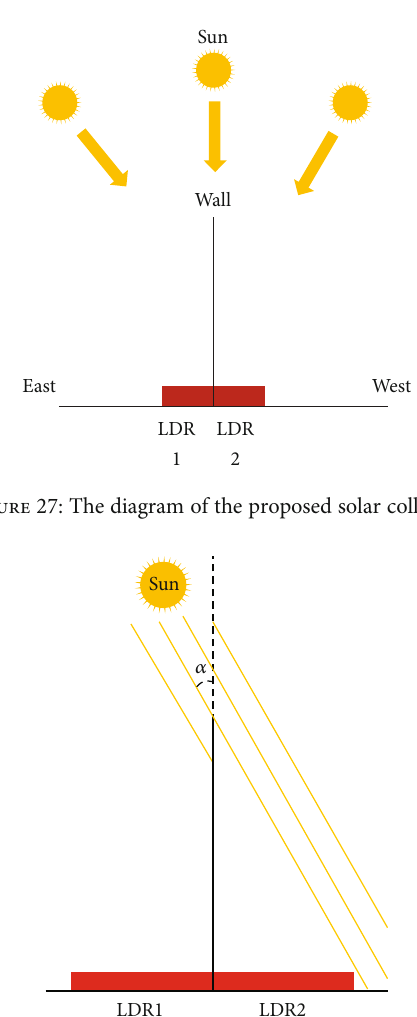
Figure 24: The motorization of the tracking axis.